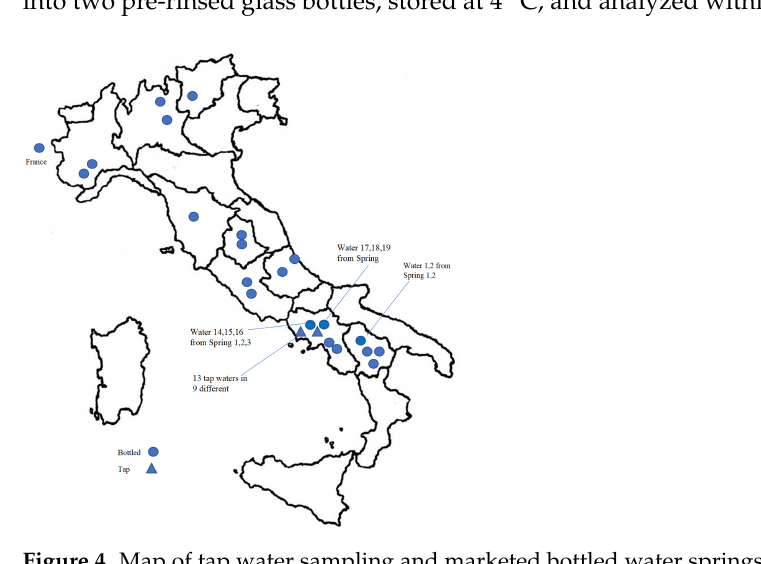
Figure 4. Map of tap water sampling and marketed bottled water springs. Waters 1, 2, 14–16, and 17–19 were of different brand and different spring in the same area; tap waters, were sampled in different cities (Waters 21, 22, 27, 29, 30, 34–36) or in the same city, but served by different aqueducts or pipelines (city 1: Waters 23, 28; city 2 Waters